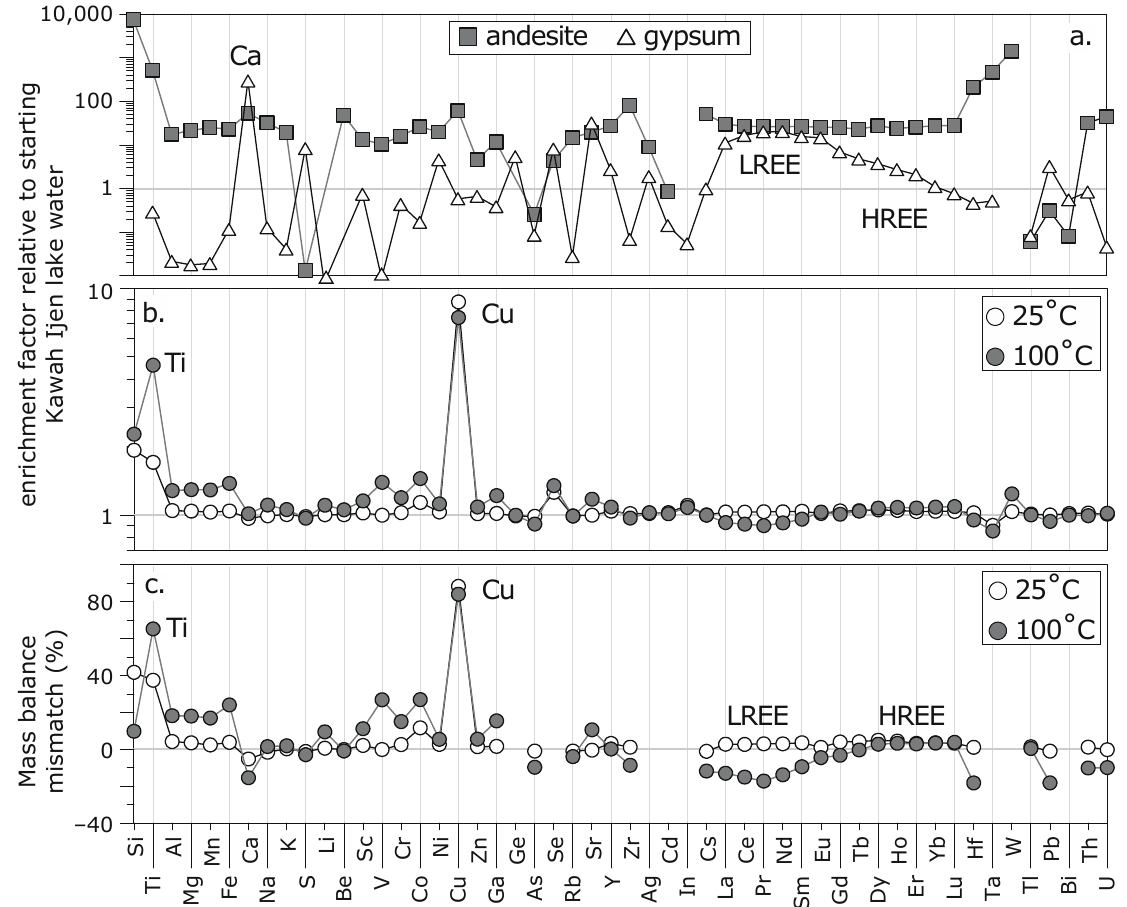
Figure 5. Enrichment factors for ( a ) andesite, gypsum and ( b ) the run product fluids relative to the starting solution, and ( c ) the % mismatch in composition for a mass balance calculation assuming incongruous andesite dissolution (see text for details on mass balance calculation).